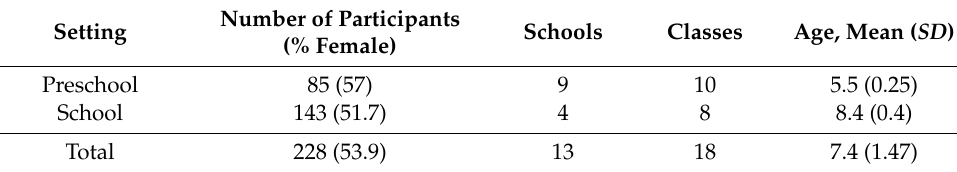
Table 1. Sample characteristics of age, gender and school